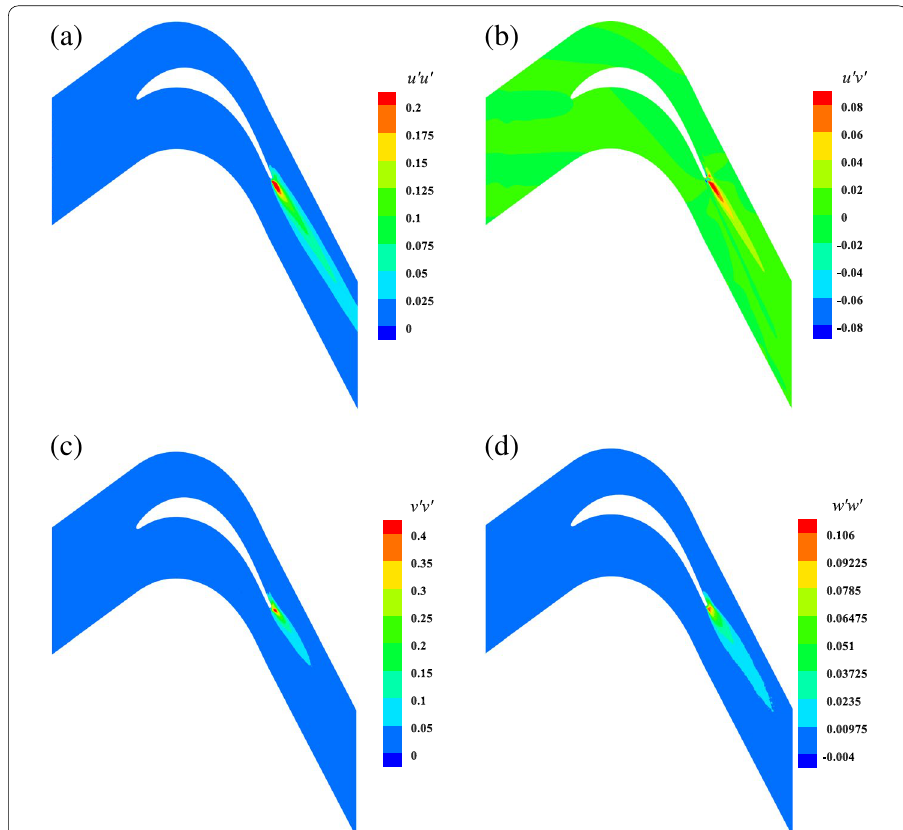
Fig. 8 Time- and spanwise-averaged Reynolds stress with uniform inflow condition: ( a ) u’u’ ; ( b ) u’v’ ; ( c ) v’v’ ; ( d )